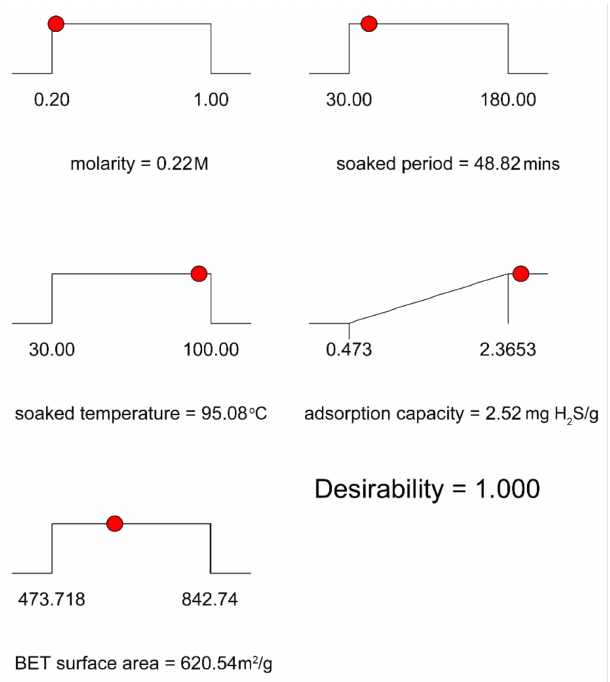
Figure 8. Optimum conditions according to the BBD statistical